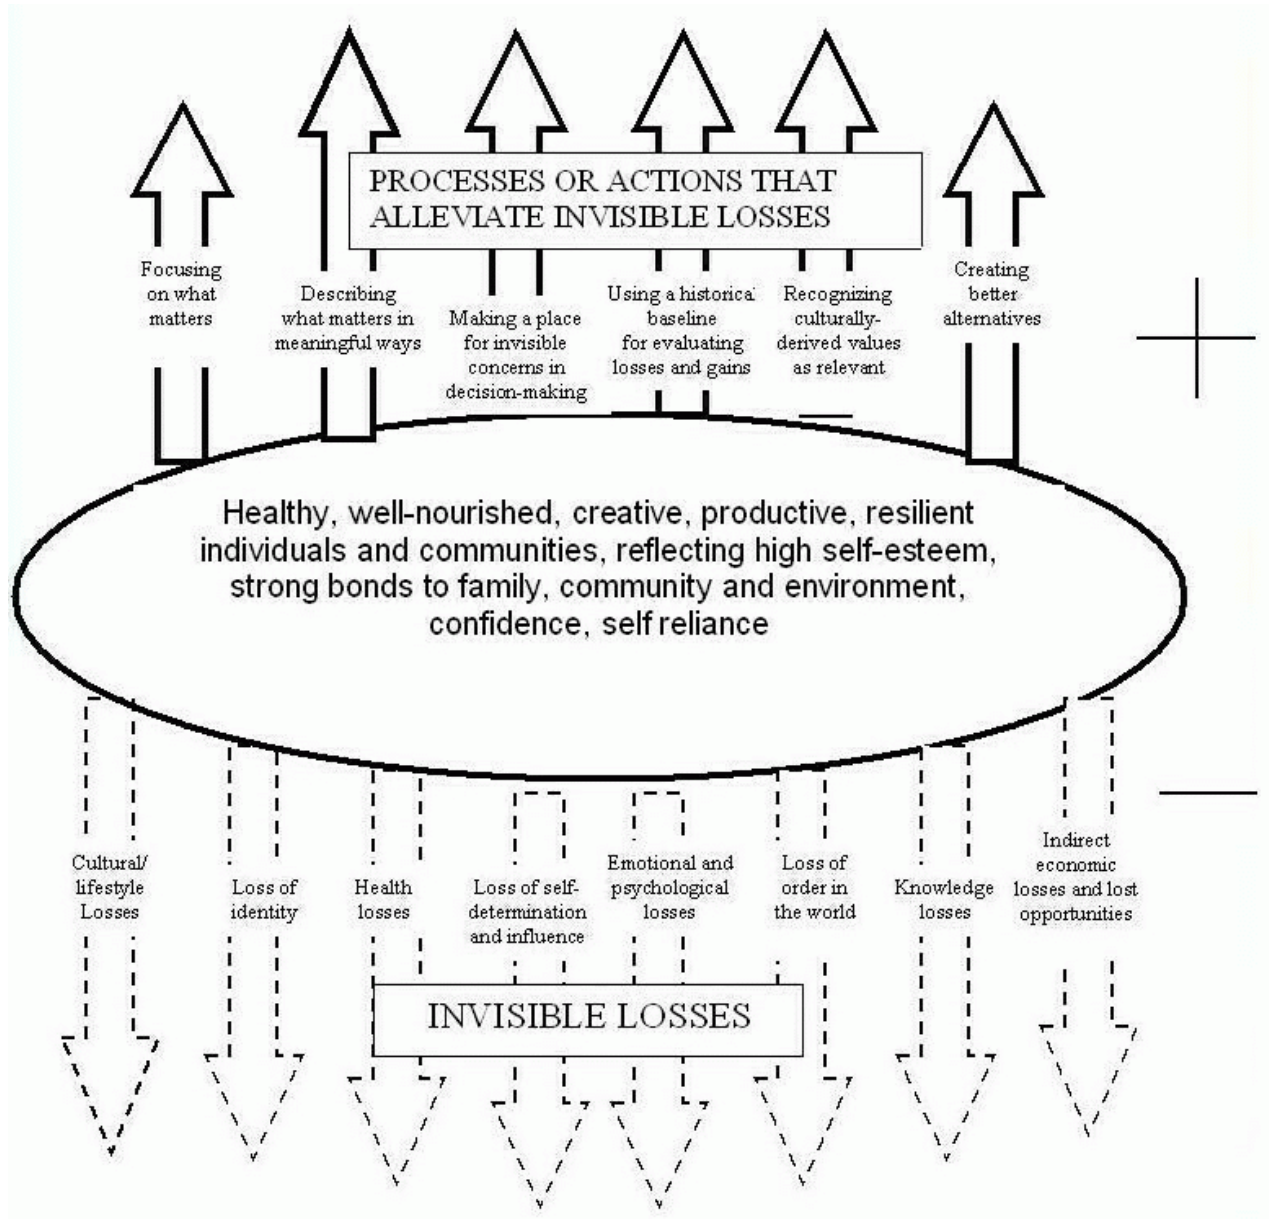
Fig. 1 . Schematic diagram showing eight identified types of invisible losses, to be addressed or counteracted by six processes that may help alleviate these types of